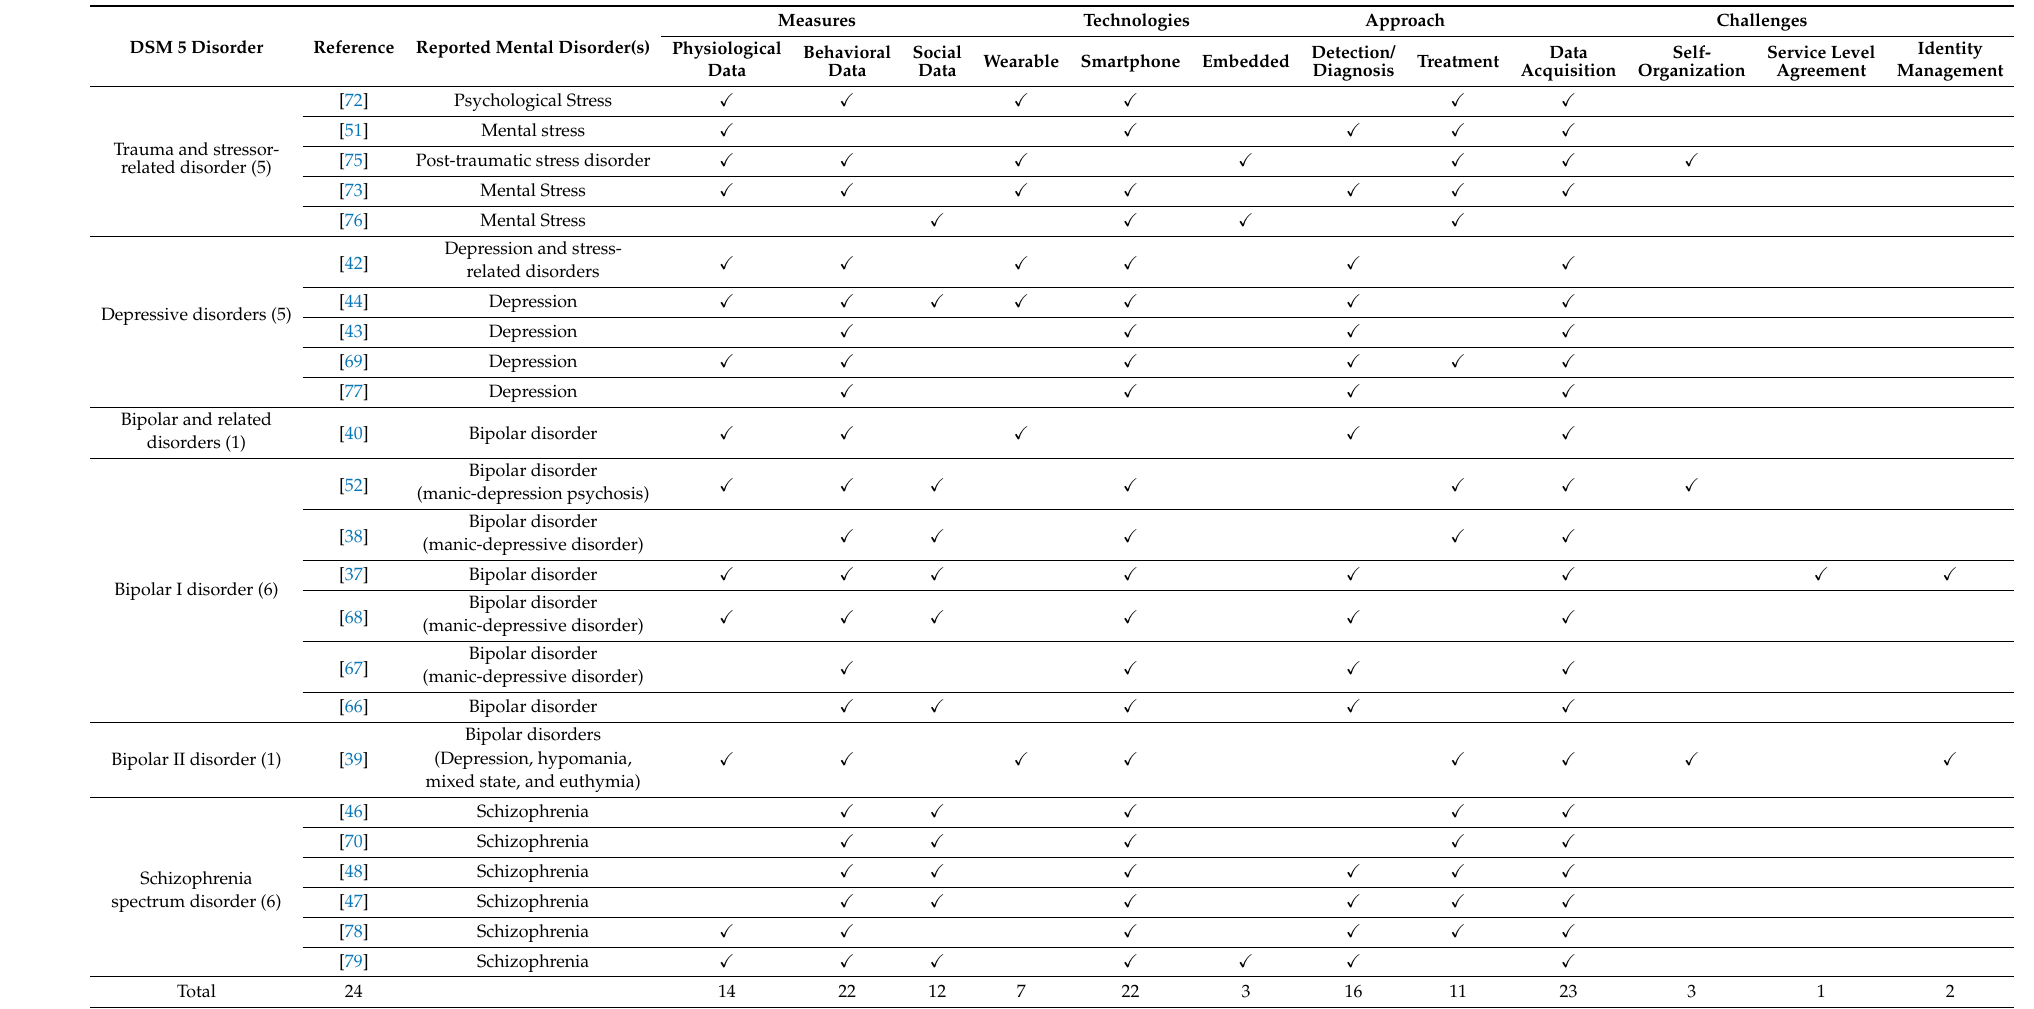
Table 1. Studies in IoT-enabled systems for mental